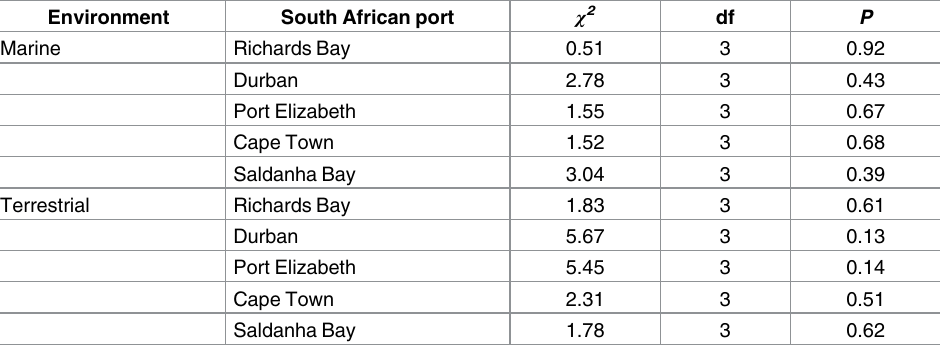
Table 2. Results of Kruskal-Wallis tests testing for seasonal variation in the relative contribution of shipping routes from foreign ports to the marine and terrestrial establishment debt of the South Afri- can ports.